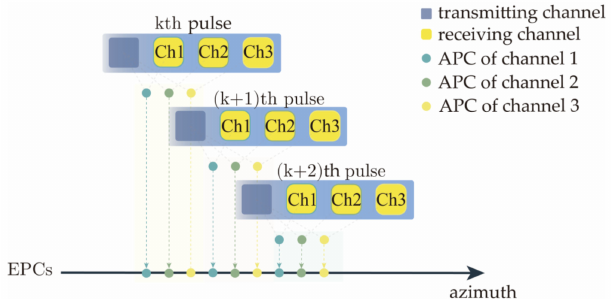
Figure 2. Azimuth multichannel signal reconstruction